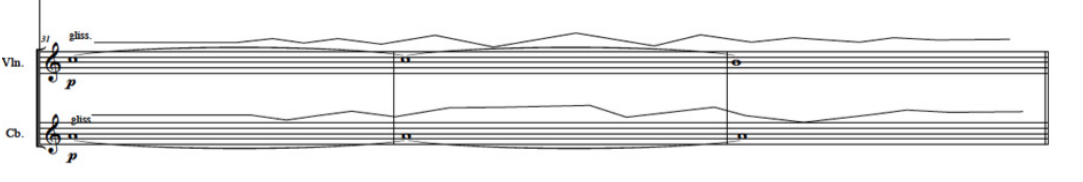
Figure 7. Free semitone bends.